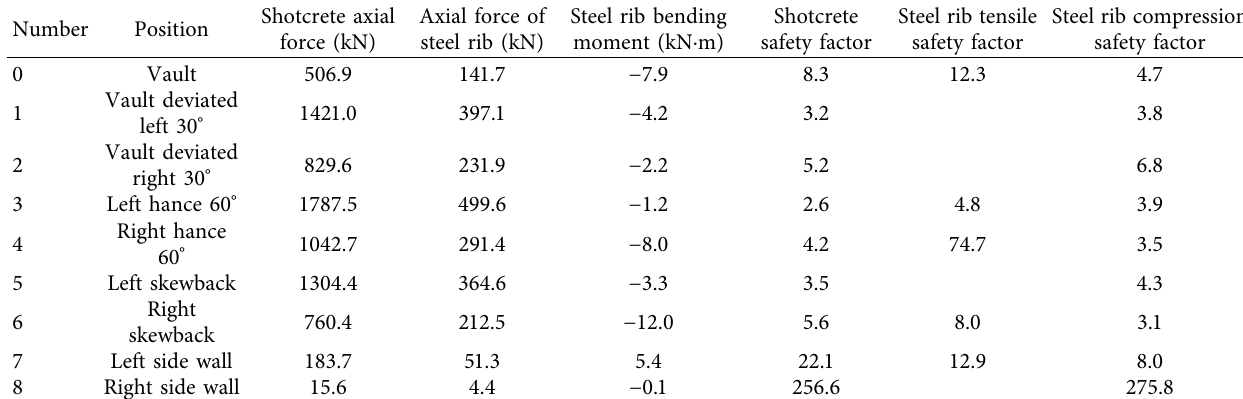
Figure 21: Deformation nephogram of YK2+449 section. (a) Crown settlement. (b) Horizontal convergence. Table 6: Primary support internal force and material safety